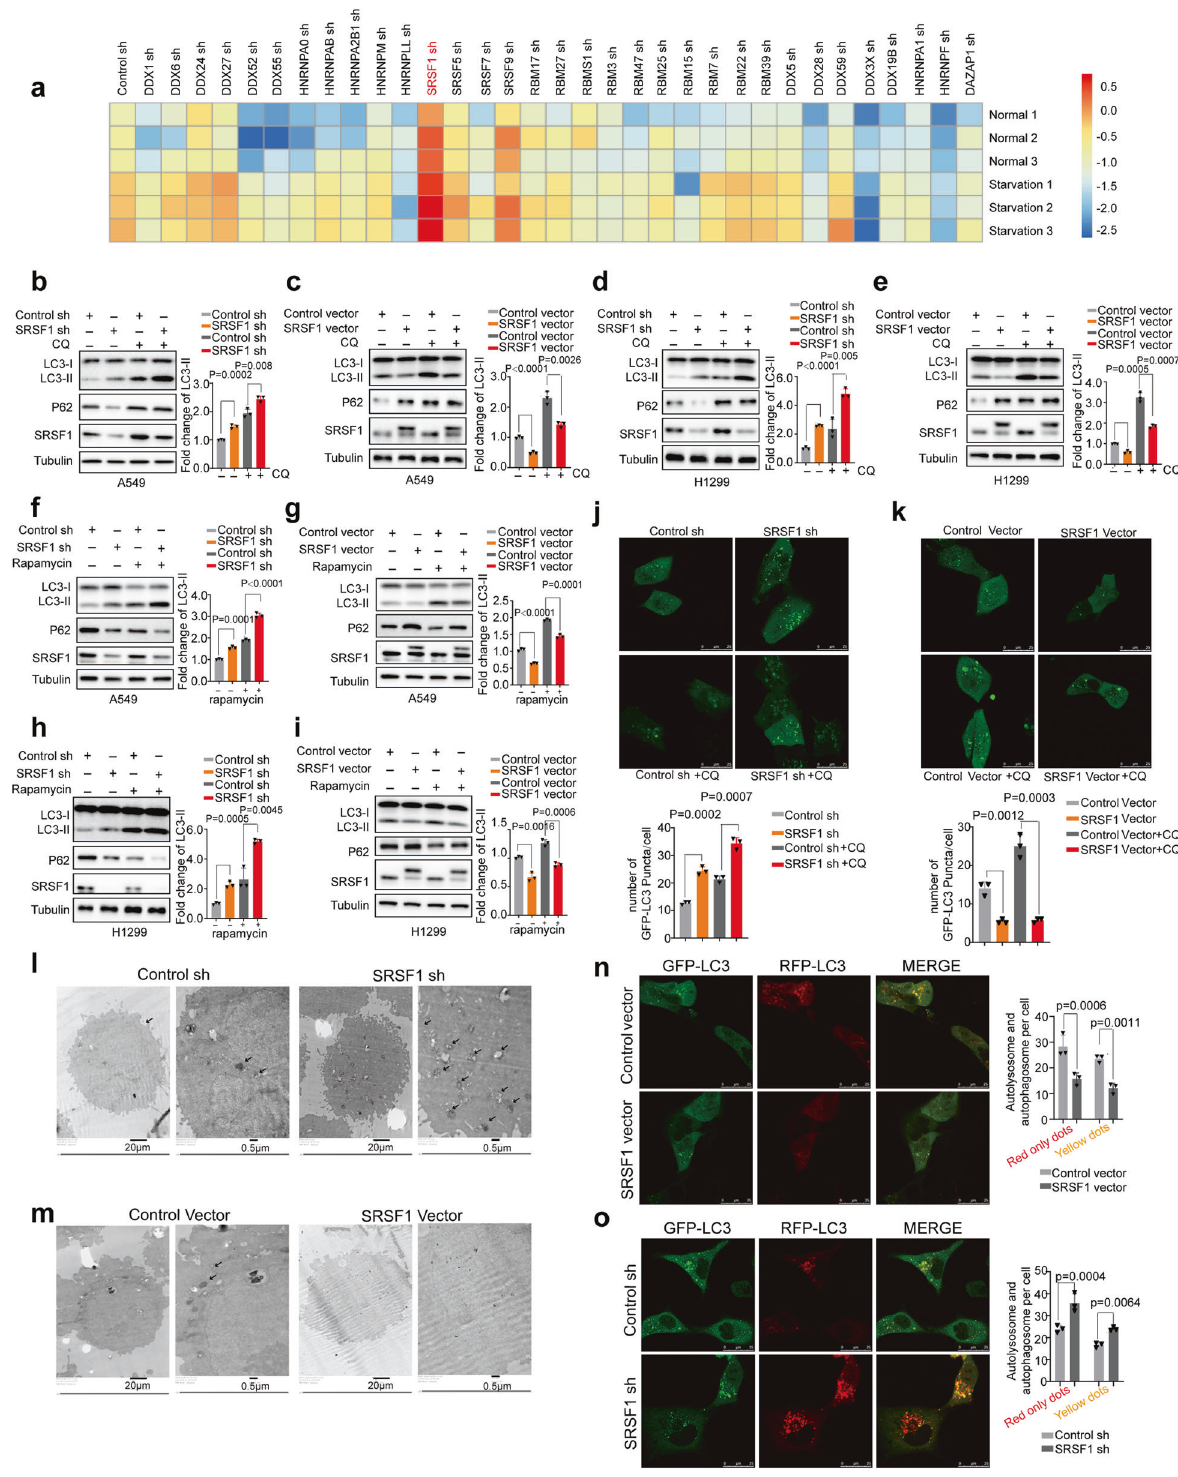
splicing regulation by SRSF1 (Fig. 2f, g). Further RNA-IP assays with wild-type or mutated reporters con fi rmed our fi ndings that the SRSF1-binding is indeed dependent on the CGGCGG site, as the mutation of this site almost completely prevented the interaction of SRSF1 with the Bcl-x pre-mRNA in both H1299 and 293 T cells (Fig. 2h and Supplementary Fig. 2e). This splicing shift led by SRSF1 also resulted in a robust change of Bcl-xL protein